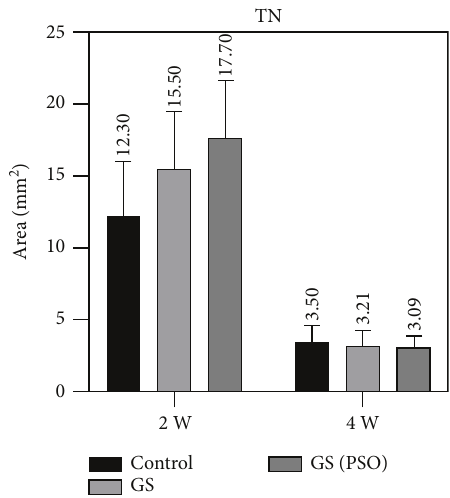
Figure 12: A bar chart representation of the mean and standard deviation of bone cells after 2- and 4-week time intervals, con- sidering